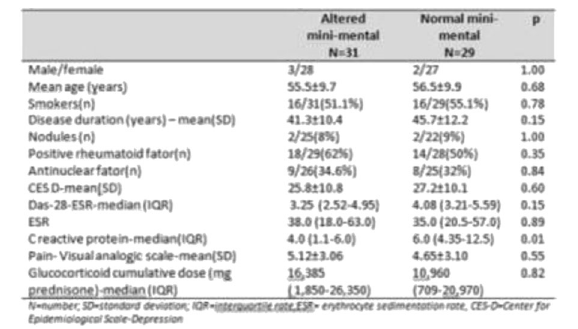
Table 1 (abstract P122). COMPARISON OF RA PATIENTS WITH NORMAL AND ALTERED MINI-METNAL (SCORES CORRECTED FOR EDUCATIONAL